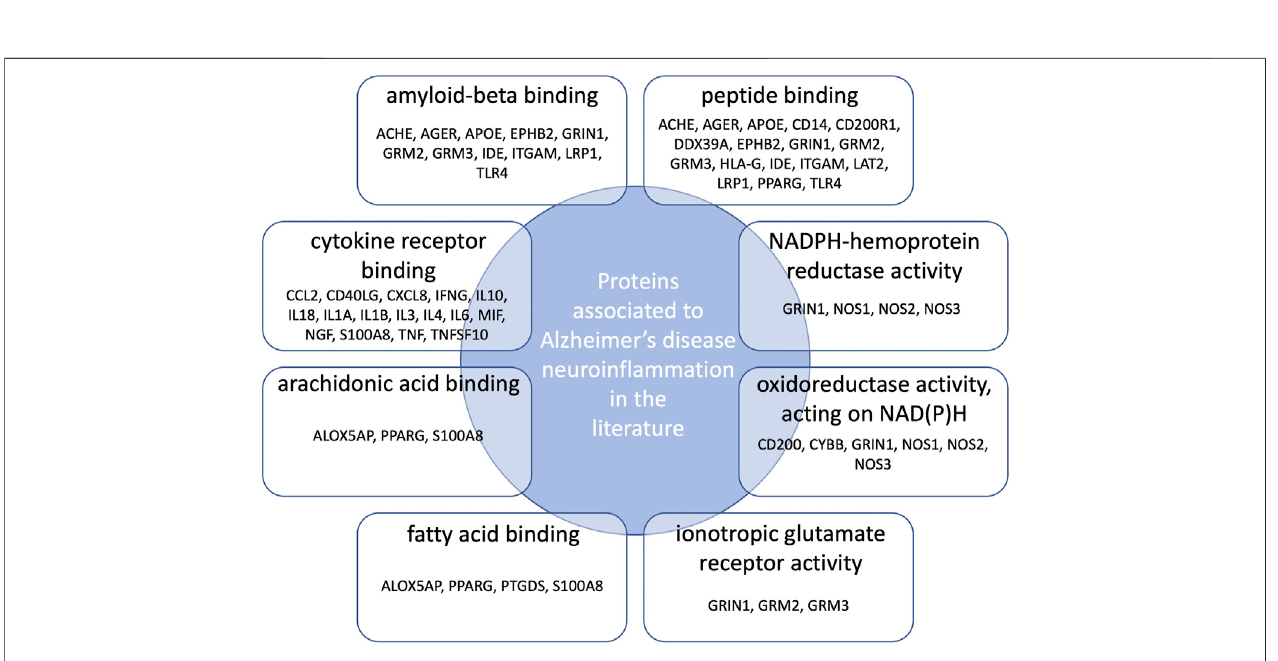
FIGURE 3 | Connections between proteins associated to neuroin fl ammation in Alzheimer ’ s disease and the top eight over-represented molecular functions annotations. Protein names are those belonging both to our dataset and the enriched GO molecular functions annotations.